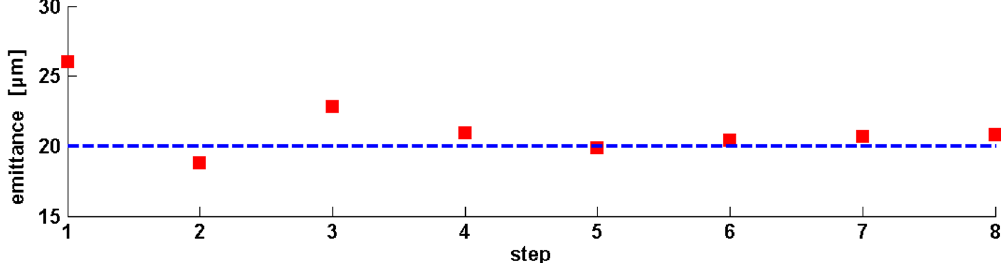
FIG. 4. Plot showing convergence of emittance for an elliptical beam with medium space charge ( K ¼ 2 : 83 (cid:3) 10 (cid:1) 4